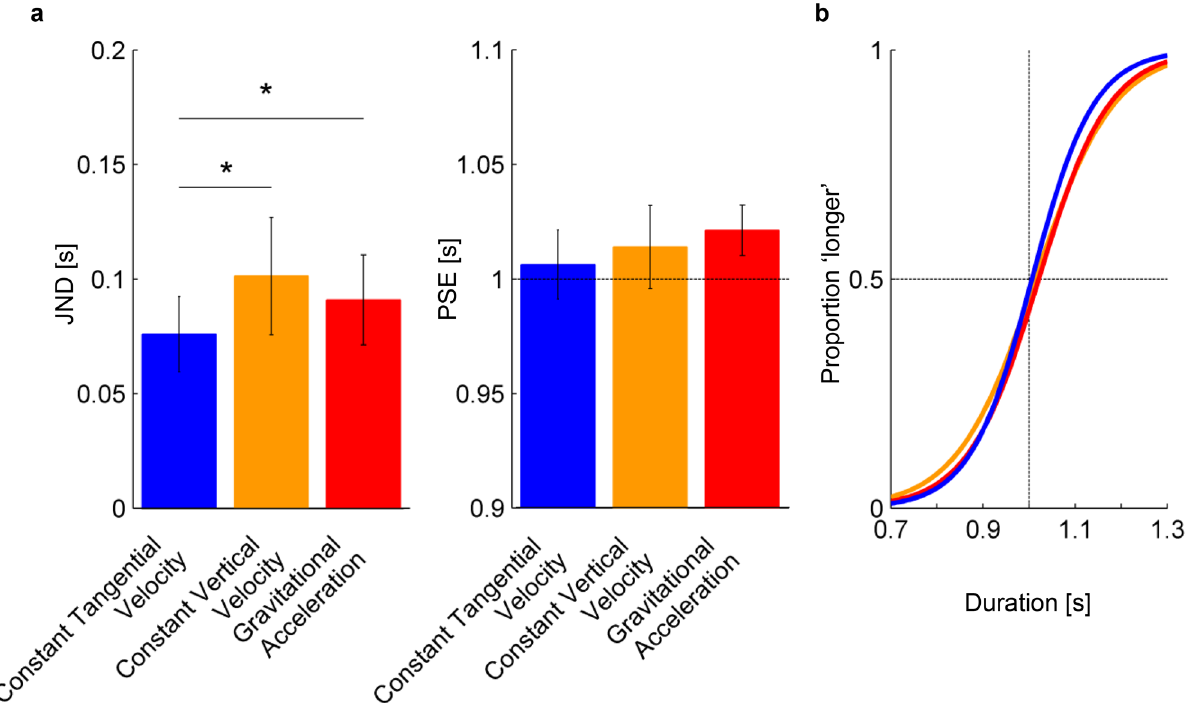
Figure 5. Panel a: JND and PSE for the three laws of motion (mean values and 95%-CI, n = 15 participants). For PSE, the dotted horizontal line denotes the duration of the reference stimulus (1 s). * P < 0.05 (corrected for multiple comparisons). Panel b: Psychometric functions predicted by the GLMM. Blue, orange and red curves correspond to constant tangential velocity, constant vertical velocity, and gravitational acceleration, respectively. The vertical line denotes the reference duration (1 s).